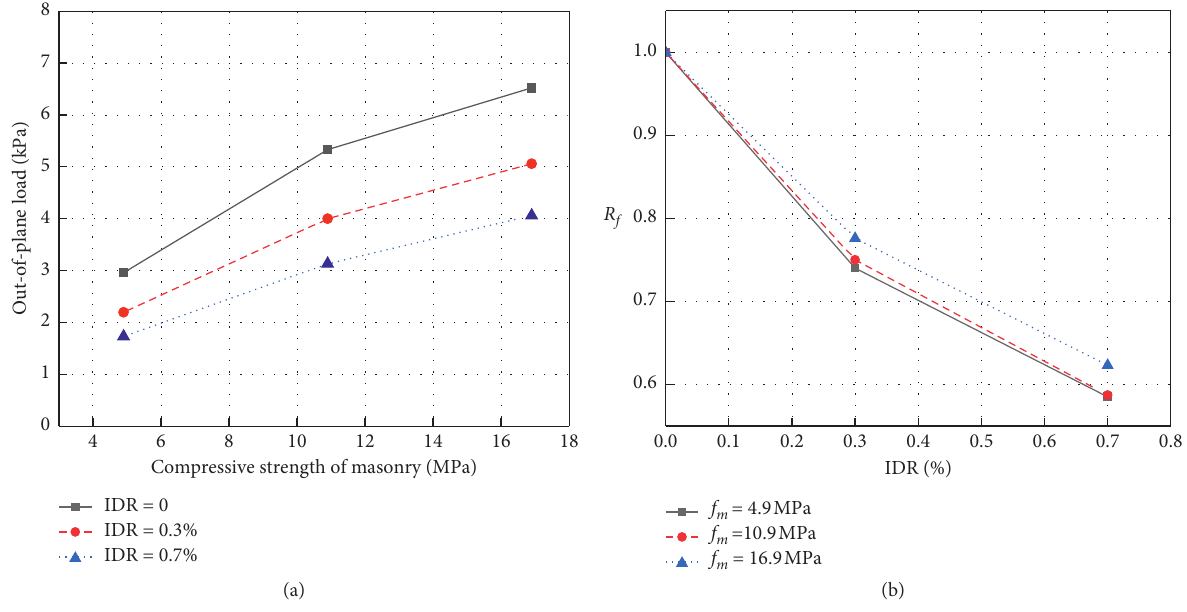
Figure 14: The effect (a) masonry strength and (b) IP damage on the OOP strength of the infill wall.